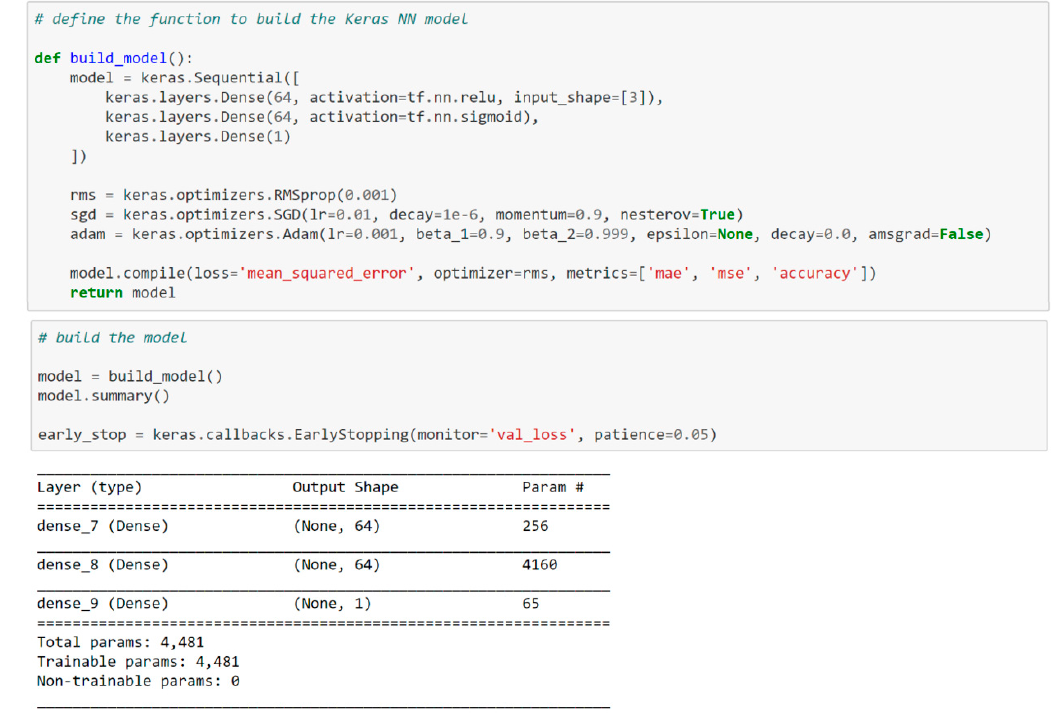
Figure 7. Defining the Keras training model.